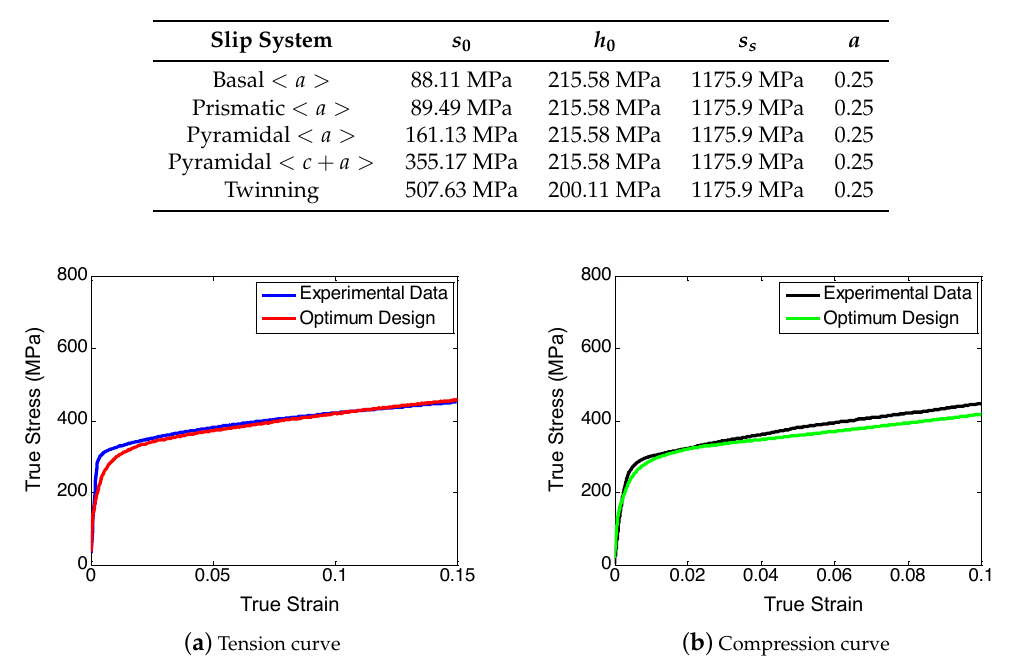
Figure 1. True strain-true stress curve comparison of experimental data and optimum design for Ti-0Al.